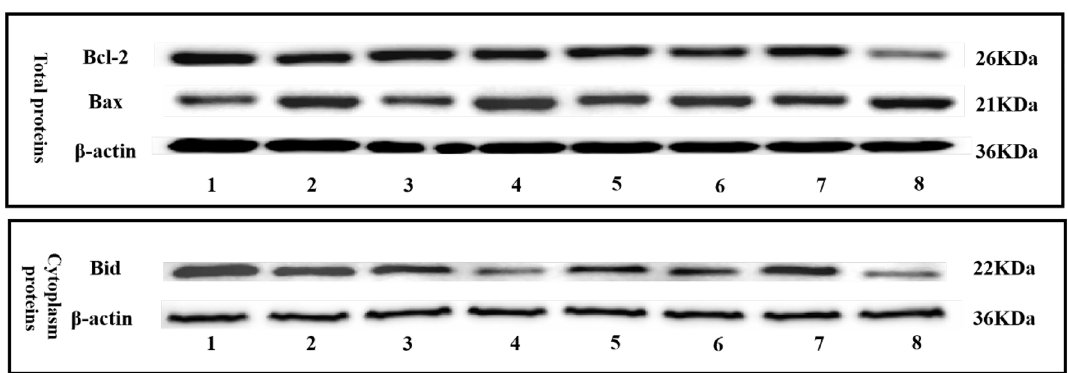
Figure 21. The protein expression alterations of Bid, Bcl-2 and Bax and in different treatment groups. IPEC-J2 was treated for 24 h. The different treatments were 1. Control treatment (T1); 2. SBA treatment (T9); 3. KRT8- siRNA treatment (T2); 4. KRT8-siRNA + SBA treatment (T10); 5. KRT18-siRNA treatment (T3); 6. KRT18- siRNA + SBA treatment (T11); 7. ACTA-siRNA treatment (T4); and 8. ACTA-siRNA + SBA treatment (T12). The expressions of the cytosolic Bid, Bcl-2 and Bax were determined using western blot. β-actin served as an internal